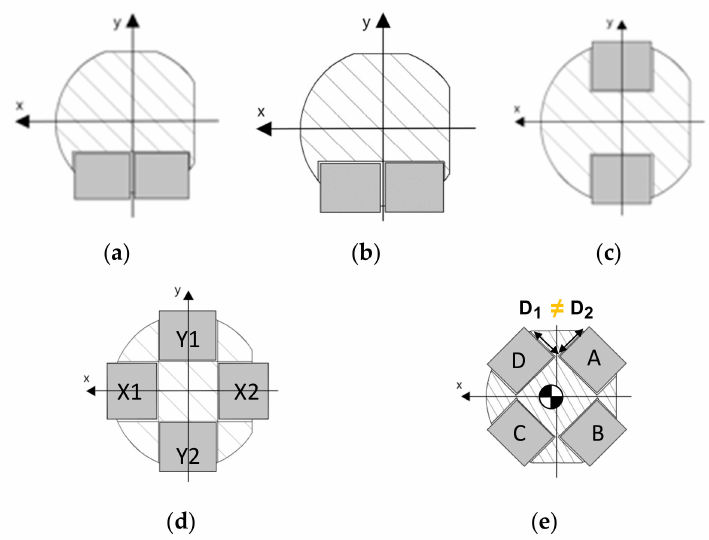
Figure 4. Evaluated solutions of ( a ) one actuator ( b ) two parallels actuators, ( c ) two side actuators, ( d ) four actuators along x and y direction and ( e ) selected